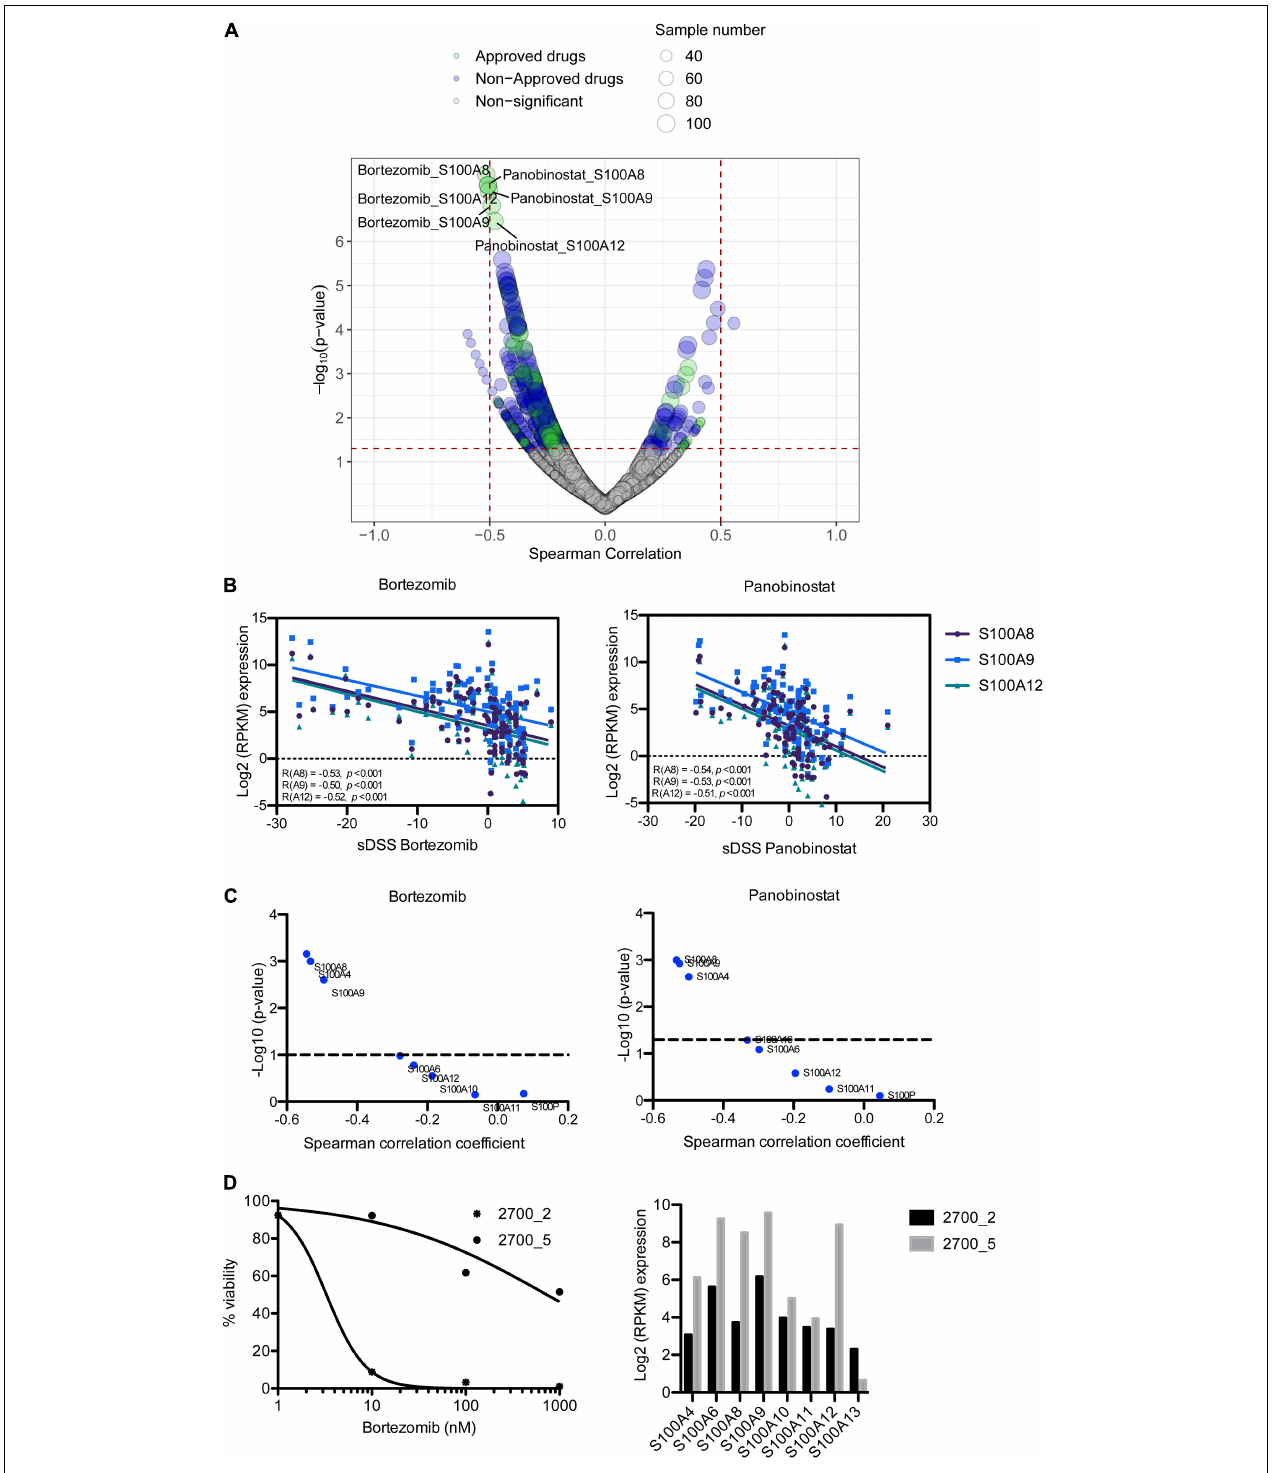
FIGURE 4 | Correlation of S100 expression with ex vivo drug response of MM patient samples. (A) Representation of correlating drug sensitivity with S100 gene expression. Dot size indicates the number of tested MM patient samples, whereas dot color indicates approval status of the drugs. (B) High expression of S 100A8 , S100A9, and S100A12 has a negative correlation with bortezomib sensitivity. (C) p -value distribution of S100 protein associated with the sensitivity to bortezomib and panobinostat. (D) Bortezomib sensitivity and expression of S100A8 , S100A9, and S100A12 in serial samples from patient 2700, who had complete remission in first line (2700_2) and no response at relapse (2700_5) with bortezomib-dexamethasone-lenalidomide treatment.